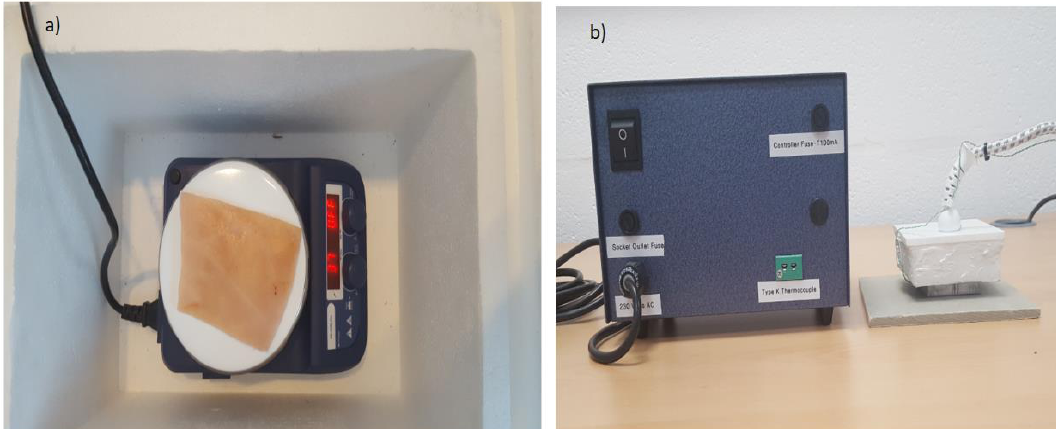
Figure 5. A digital hotplate used for heating and stabilizing the surface temperature of the porcine skin samples ( a ) and a heat control device with (50 × 50 mm) metal plate used for performing burns on the porcine skin samples ( b